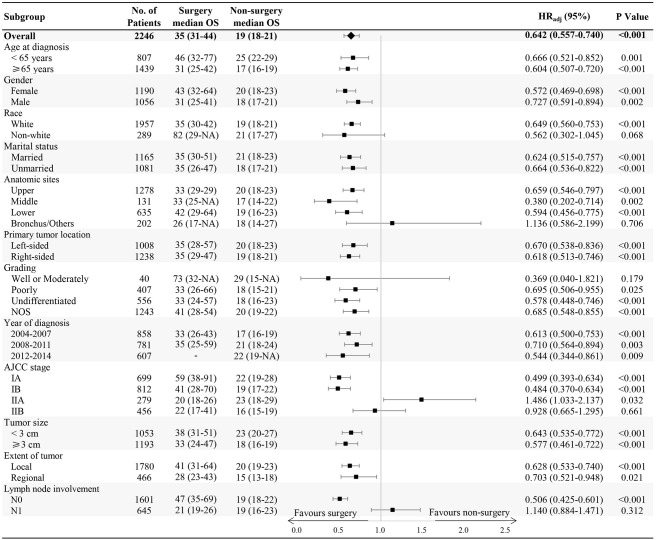
Forest plot of the subgroup analysis.